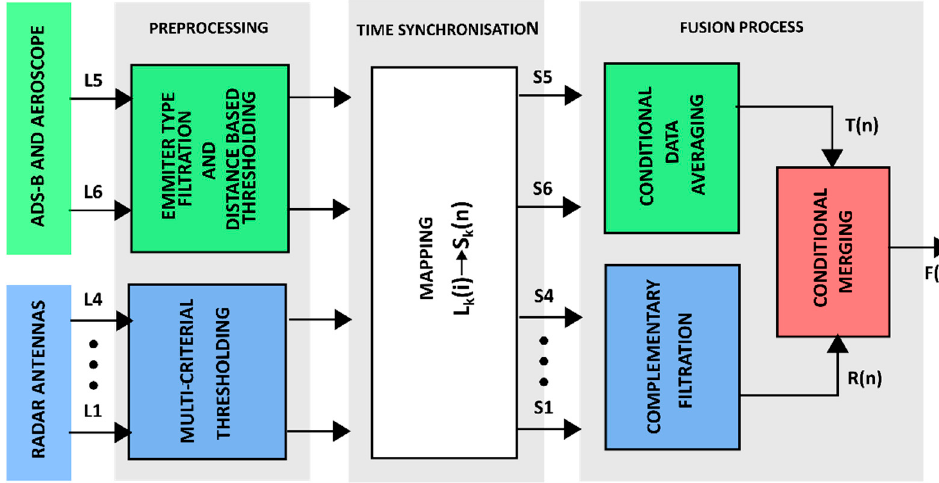
Figure 6. Diagram illustrating sensory fusion concept.